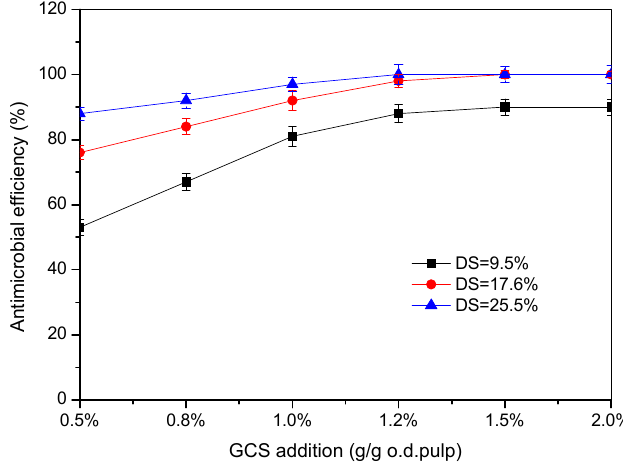
Figure 7. Effects of addition amount of GCS on the antimicrobial efficiency (equilibrium adsorption).